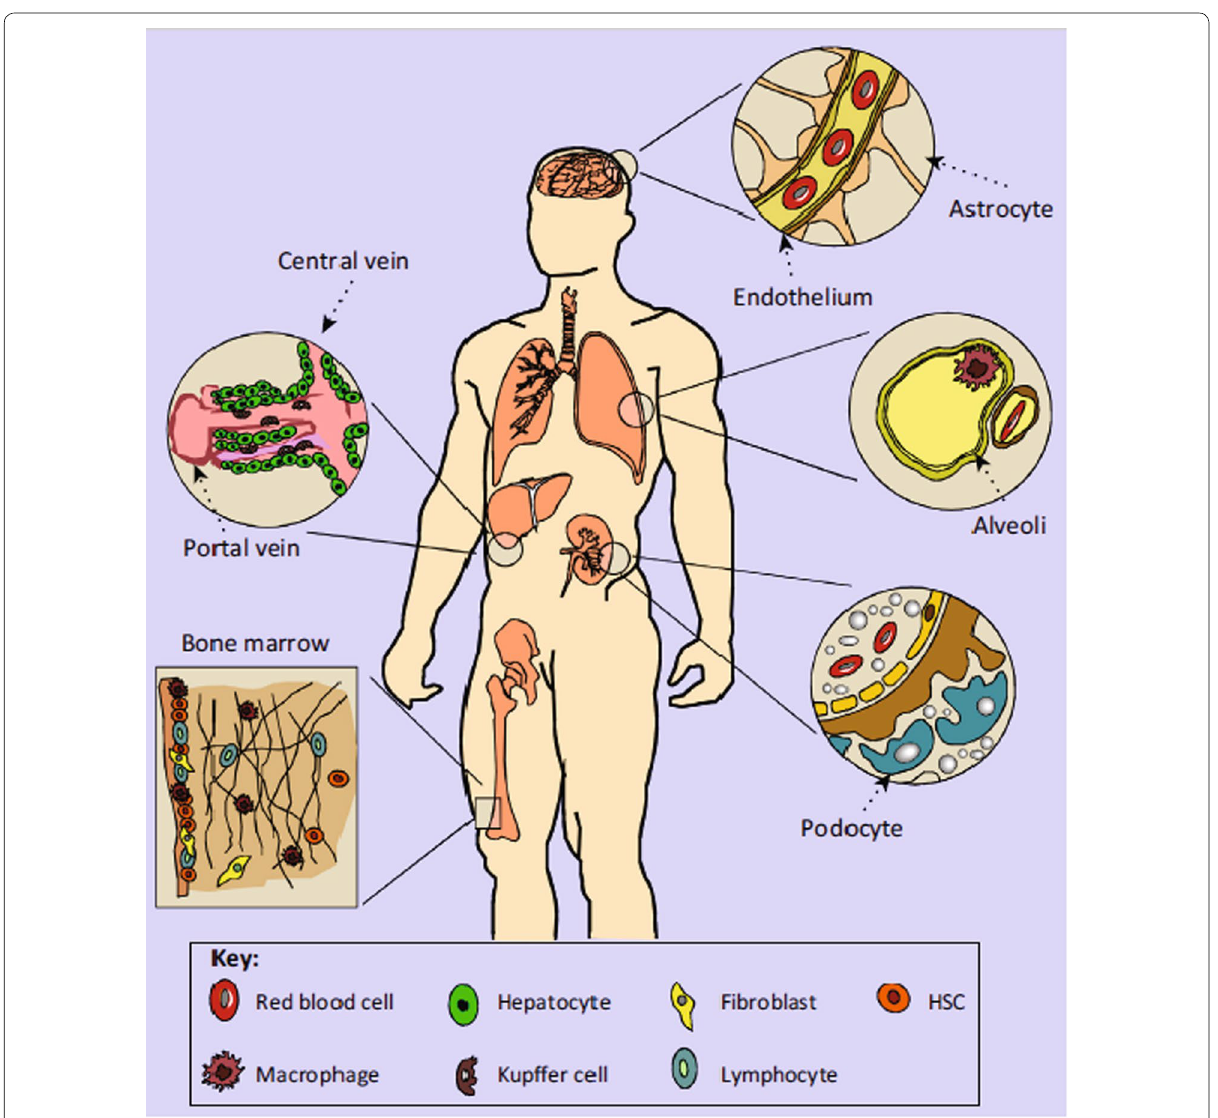
Fig. 3 Organ systems that affect nanoparticle delivery. The method of entry affects circulation time, organ processing, and overall efficacy. Intrave‑ nously injected nanoparticles can extravasate from the bloodstream and enter organs such as the liver, spleen, bone marrow, and central nervous system. Nanomedicines that are administered orally can enter the gut and pass through the liver via the hepatic portal system. Inhaled nanomedi‑ cines may contact macrophages in pulmonary alveoli. Following circulation in organs, nanoparticles may encounter renal clearance in the kidneys (Reproduced with permission from